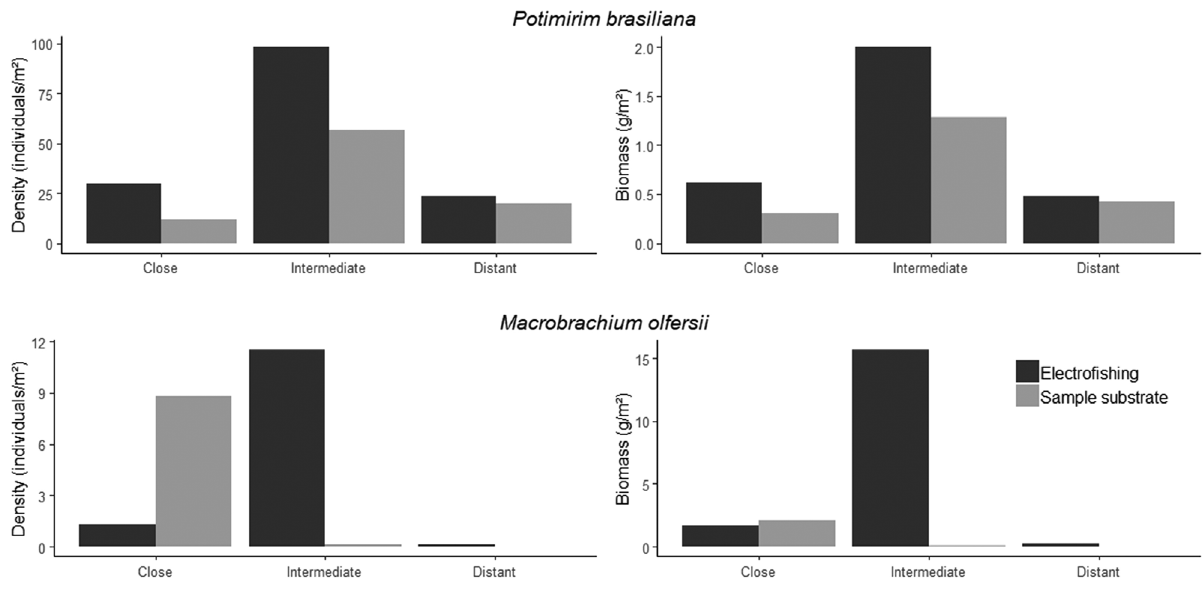
Figure 1. Density (individuals/m²) and biomass (g/m²) estimated by electrofishing (dark grey) and sample substrate (light grey) methodologies for Potimirim brasiliana (above) and Macrobrachium olfersii (below).